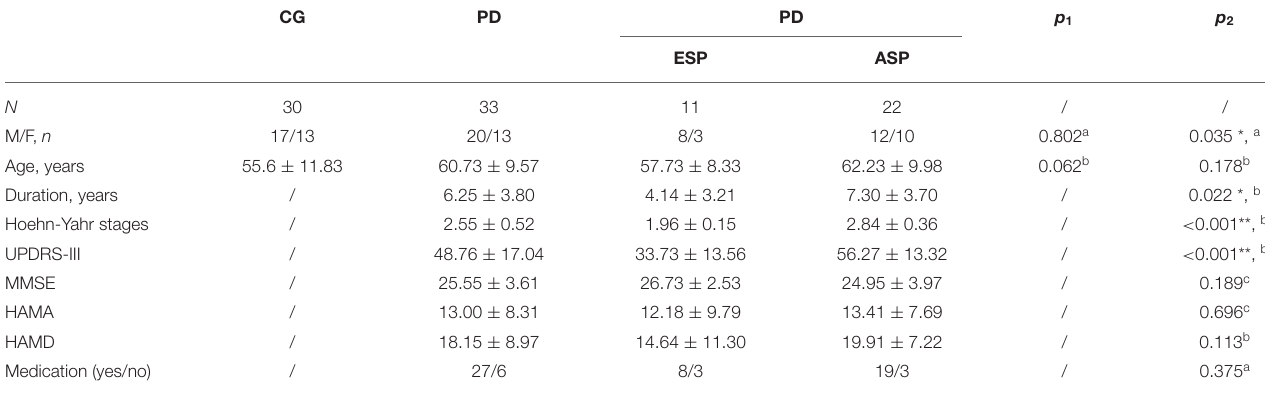
TABLE 1 | Demographics of patients with PD and control group.